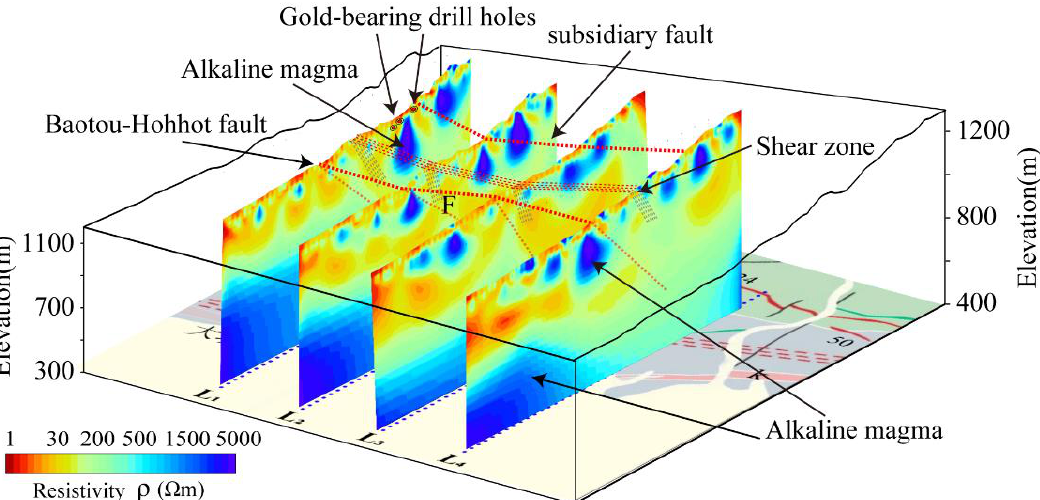
Figure 4. The comprehensive three-dimensional sketch of the 2D models of the four profiles. The layout of the four profiles on the geological map is based on their real spacing. These red dashed lines are the connection lines of the faults/subsidiary faults/shear zones in different profiles.